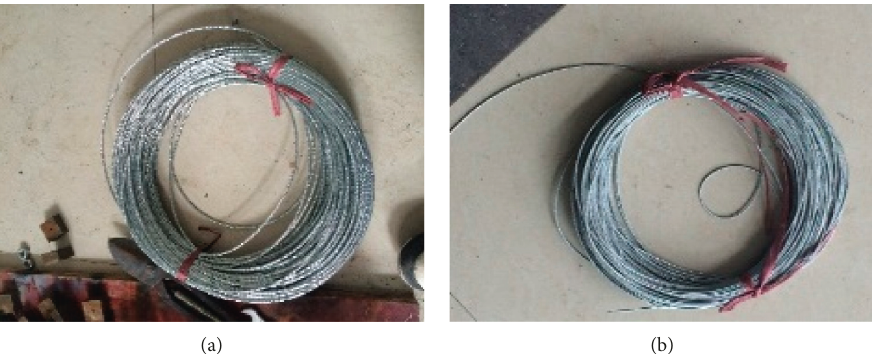
Figure 3: Physical components used for the conductor line and ground line. (a) Conductor line (4-mm steel wire). (b) Ground line (2-mm steel wire).